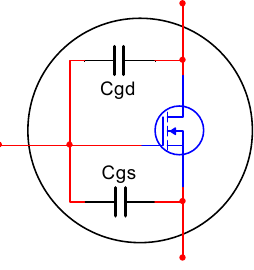
Figure 5. The input capacitance of MOSFETs.